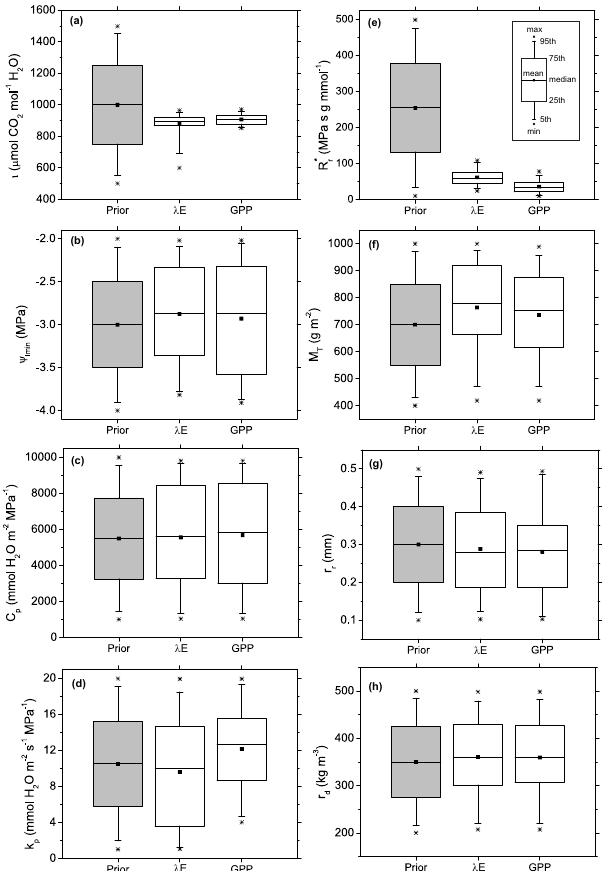
Figure 18. Root mean square error of latent heat flux from the latin hypercube sampling ( m = 500 points) in relation to (a) ι and (b) R ∗ r for US-Ha1 (July 2001) using SPA-WUE optimization. The solid lines show the polynomial regression. Analysis of GPP errors shows similar relationships (not